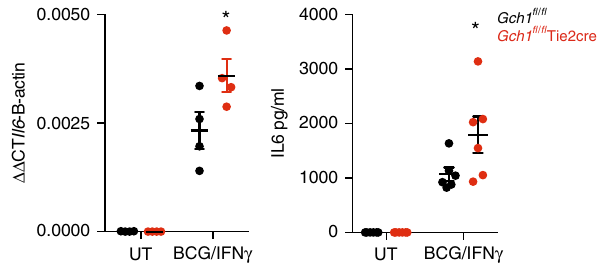
Fig. 8 Gene expression changes result in functional changes is cytokine expression. Macrophages were infected with BCG (MOI 1:1)/IFN γ (10 ng/ml) for 24 h or incubated for 24 h in the absence of infection followed by RNA extraction or ELISA analysis of the supernatant. IL-6 gene expression was quanti fi ed using TaqMan gene expression assays. Data was